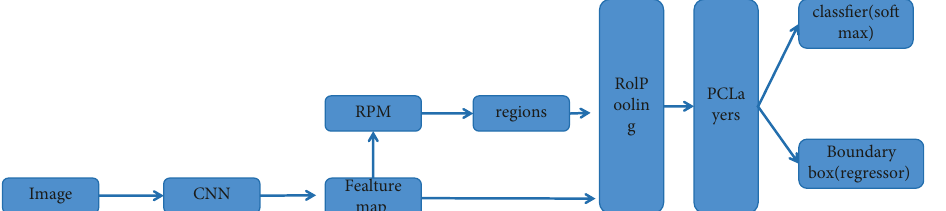
Figure 4: Structure diagram of the faster R-CNN